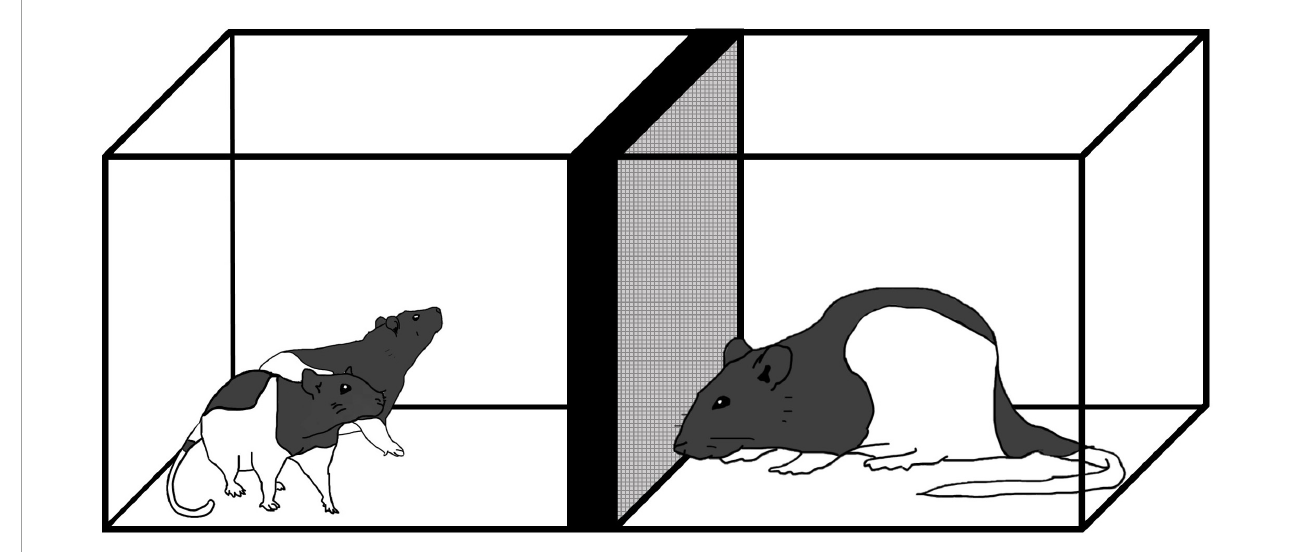
FIGURE1 Exposure to an unfamiliar adult male rat where preadolescent rats (P19–21) were exposed to an adult male for 5 min daily from